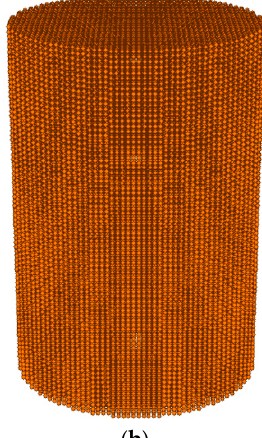
Figure 3. ( a ) Graded coarse aggregates; ( b ) uniform-sized packed discrete elements.